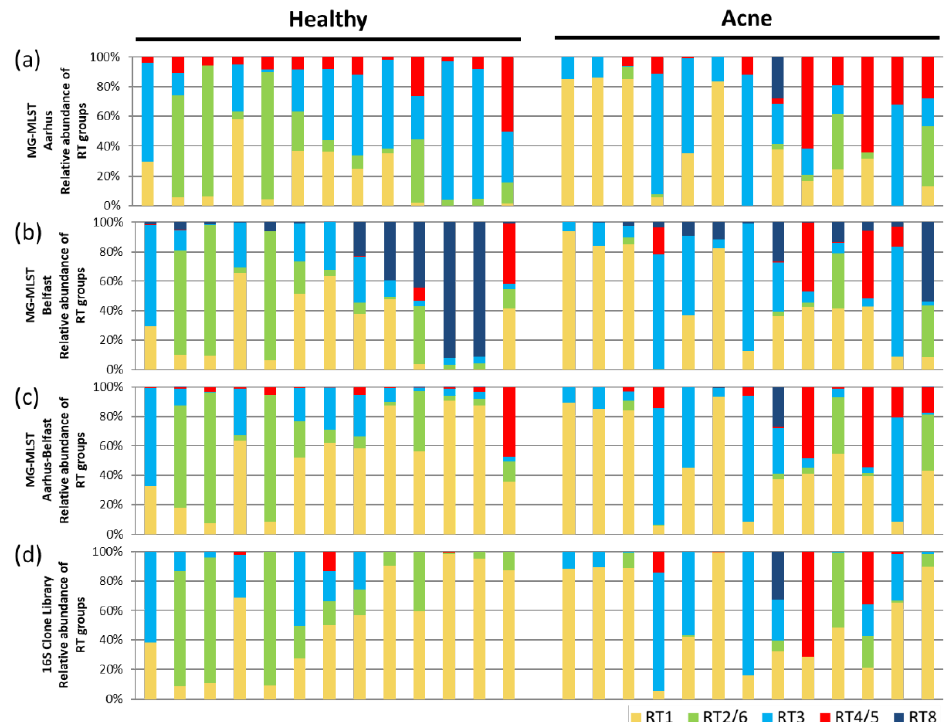
Figure 3. Comparison of the MLST schemes in predicting strain composition using MG-MLST. ( a ) Ribotype (RT) group composition predicted by STRUCTURE based on the Aahrus four gene set ( fba , lac , recA , and zno ). ( b ) RT group composition predicted by STRUCTURE based on the Belfast MLST 4 scheme ( aroE , guaA , tly , and camp2 ). ( c ) RT group composition predicted by STRUCTURE based on the combined eight gene set (Aarhus–Belfast) ( fba , lac , recA , zno , aroE , guaA , tly , and camp2 ). ( d ) RT group composition based on 16S ribotype data. Pearson’s correlations are shown in Table S3.